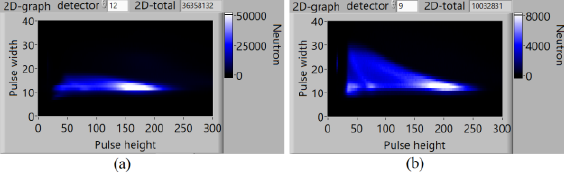
Fig. 7. PHW graphs of (a) fast PSD and (b) slow